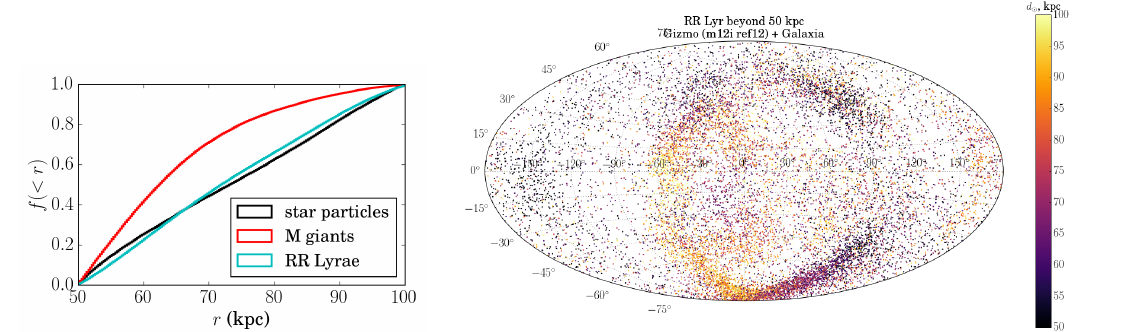
Figure 6. Left : Cumulative distance distributions for two stellar tracers, M giants (red) and RR Lyr (cyan), generated from the simulated Latte halo used in this work using a modification of the code Galaxia [42]. While the RR Lyr closely trace the distribution of star particles from the simulation (black), the M giants have significantly different, far more centrally concentrated distribution. Right : Sky distribution of the synthetic RR Lyr survey generated from the Latte halo. The color scale indicates Galactocentric